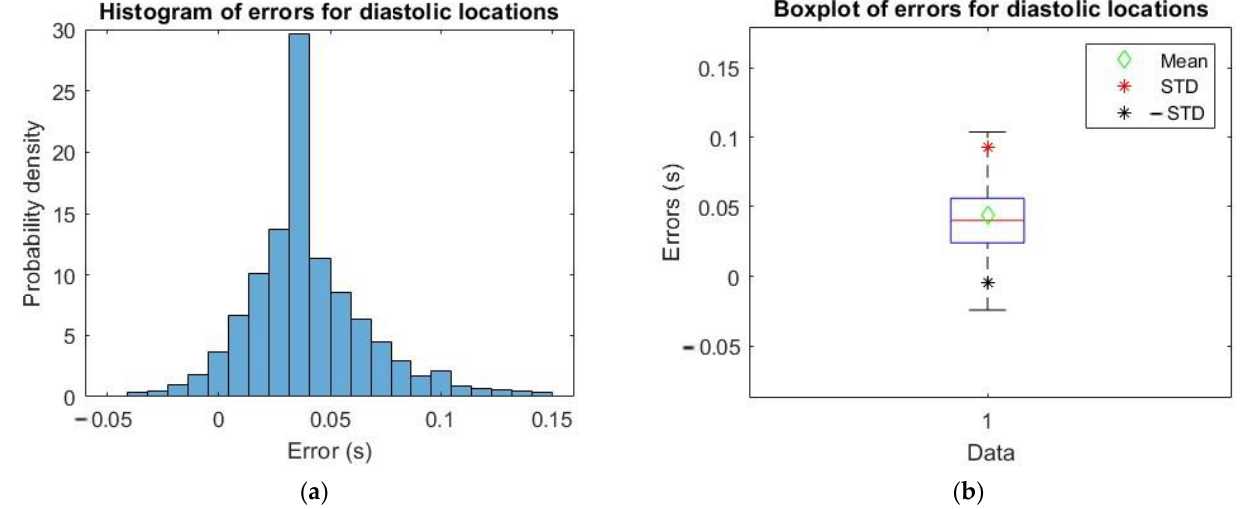
Figure 7. ( a ) Histogram of errors for systolic locations; ( b ) boxplot of errors with mean, mean + std and mean std.